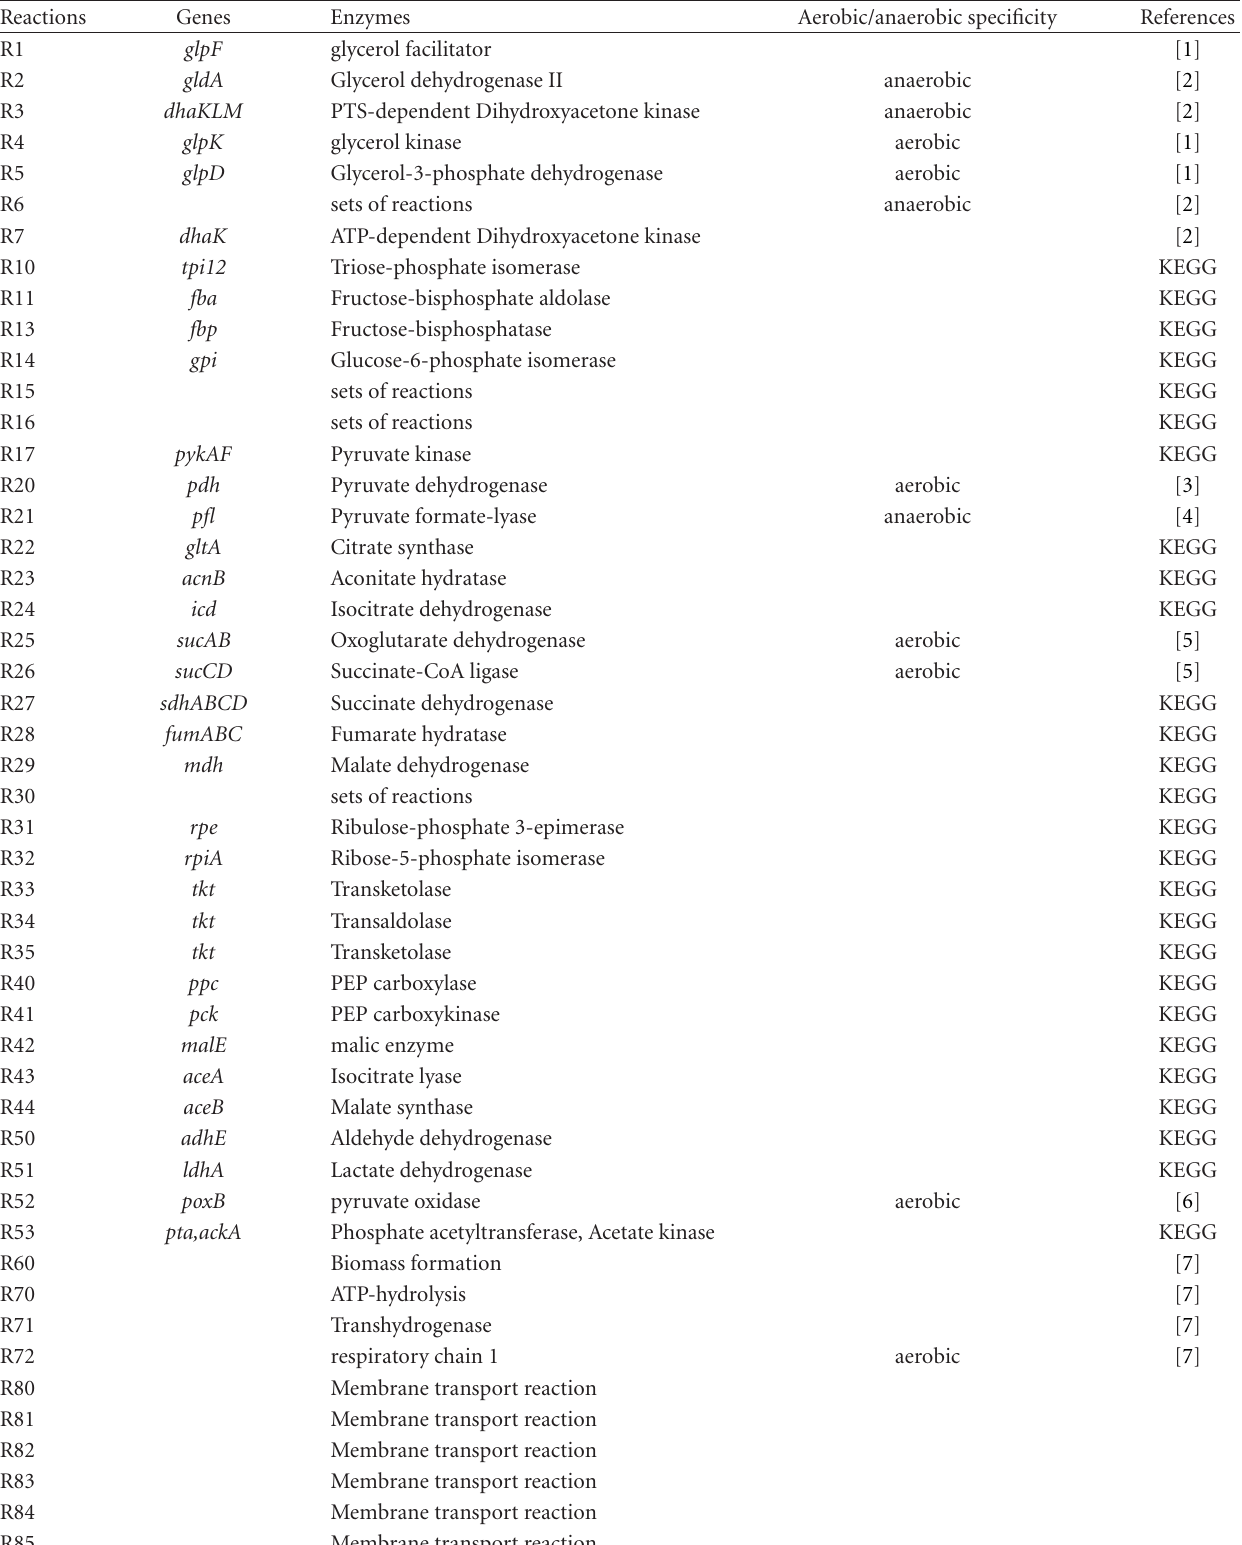
Table 1: Reactions and enzymes involved in Figure